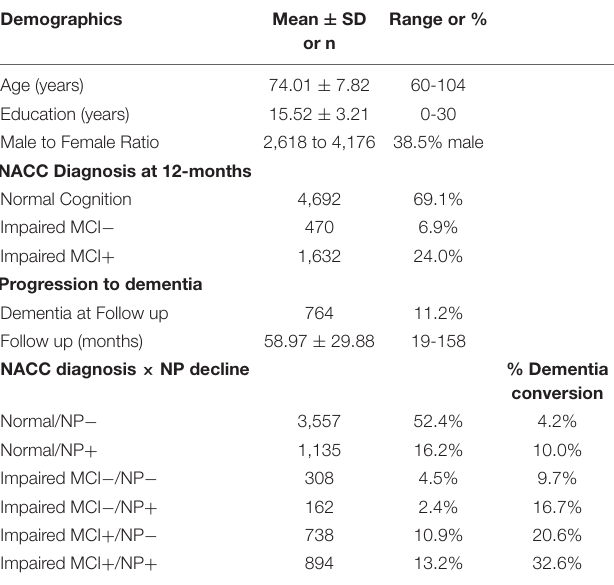
TABLE 1 | Participant demographics and clinical characteristics.